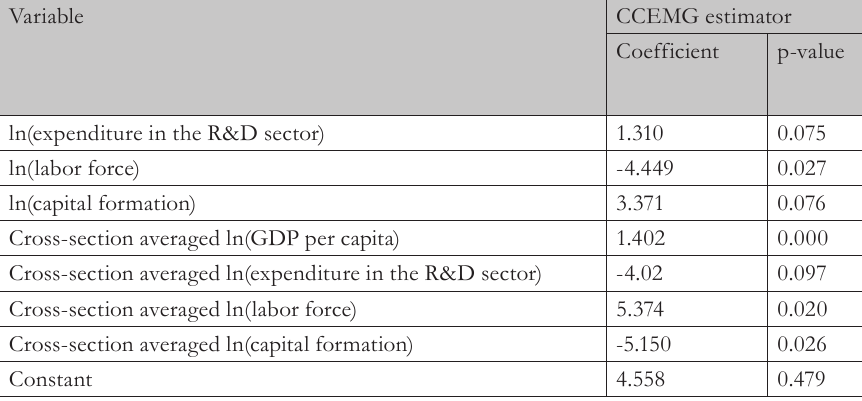
Tab. 2 − Heterogenous panel estimators for explaining GDP per capita growth in the EU-28 (2004-2018). Source: own